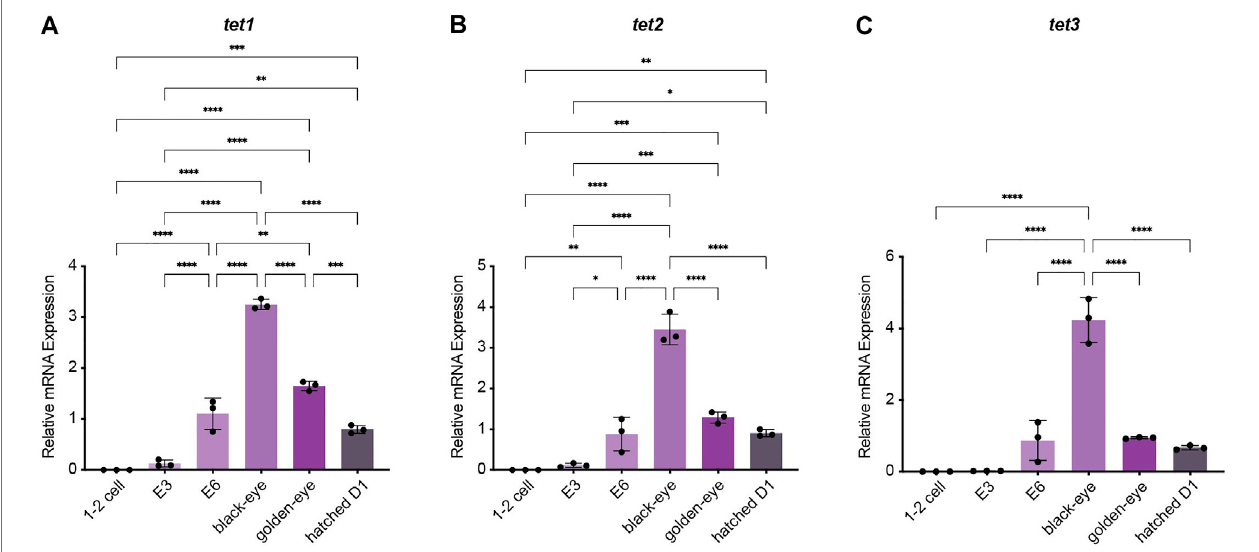
FIGURE 3 | Expression analysis of the ten-eleven translocation methylcytosine dioxygenase family during embryogenesis and post hatching. Quantitative Real- time PCR of killi fi sh tet1 (A) , tet2 (B) , tet3 (C) . Individual tet expression was normalized to tbp housekeeping gene expression. For total RNA isolation the following numbers ofembryosper biological replicate were sampled (1 – 2 cell: 200eggs; E3and E6: 100eggs; black and golden eye: 50eggs; hatched D1: 30 fi sh). Allerror bars represent SD of three biological replicates. Statistical signi fi cances were calculated with one-way ANOVA implementing Tukey ’ s multiple comparisons. All developmentalstages(1 – 2cell,E3,E6,blackeye,goldeneye,andnewlyhatched fi shD1)wherecomparedtoeach otherandrelativemRNAexpression isdepicted.ns: p > 0.05; *: p ≤ 0.05; ** p ≤ 0.01; ***: p ≤ 0.001; ****: p ≤ 0.0001.